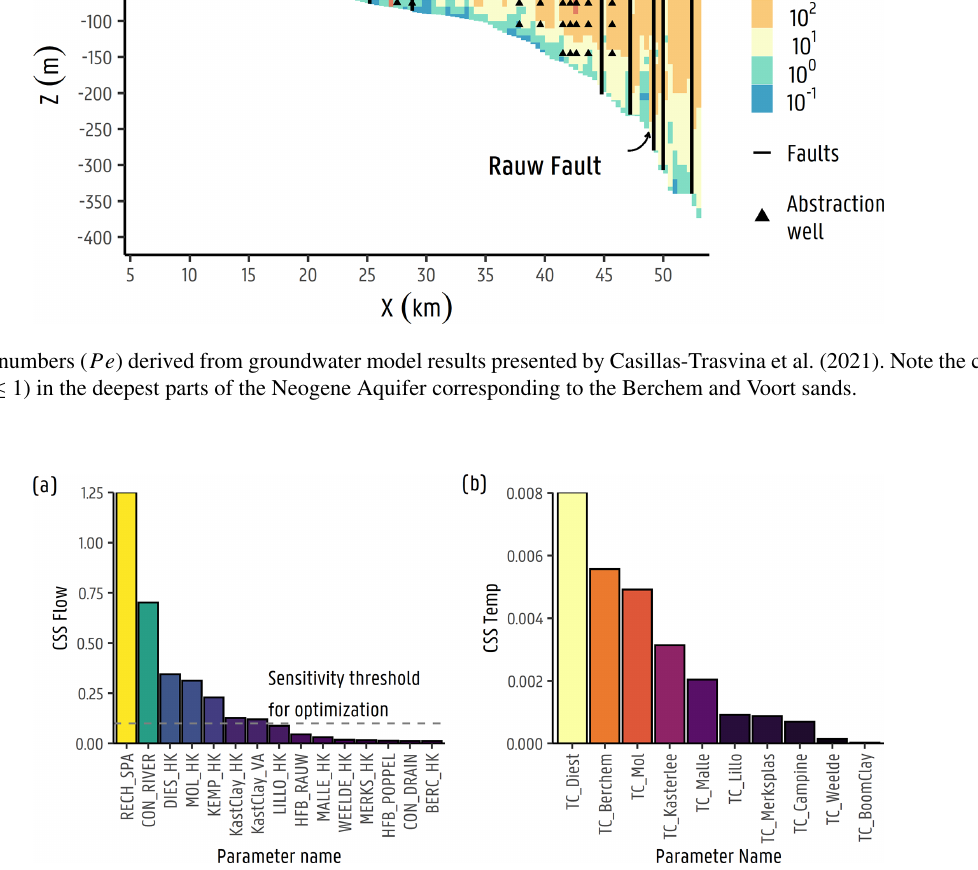
Hydrol. Earth Syst. Sci., 26, 5577–5604,